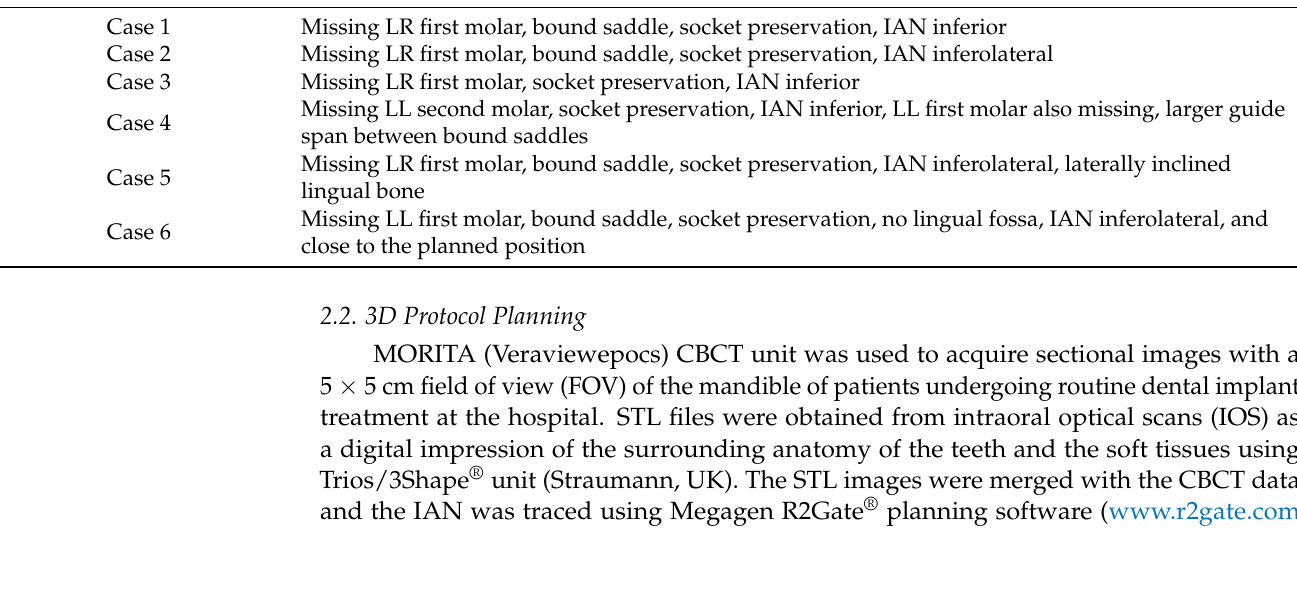
Table 1. Description of the selected cases categories. Abbreviations: lower left (LL), lower right (LR), inferior alveolar nerve (IAN). Case